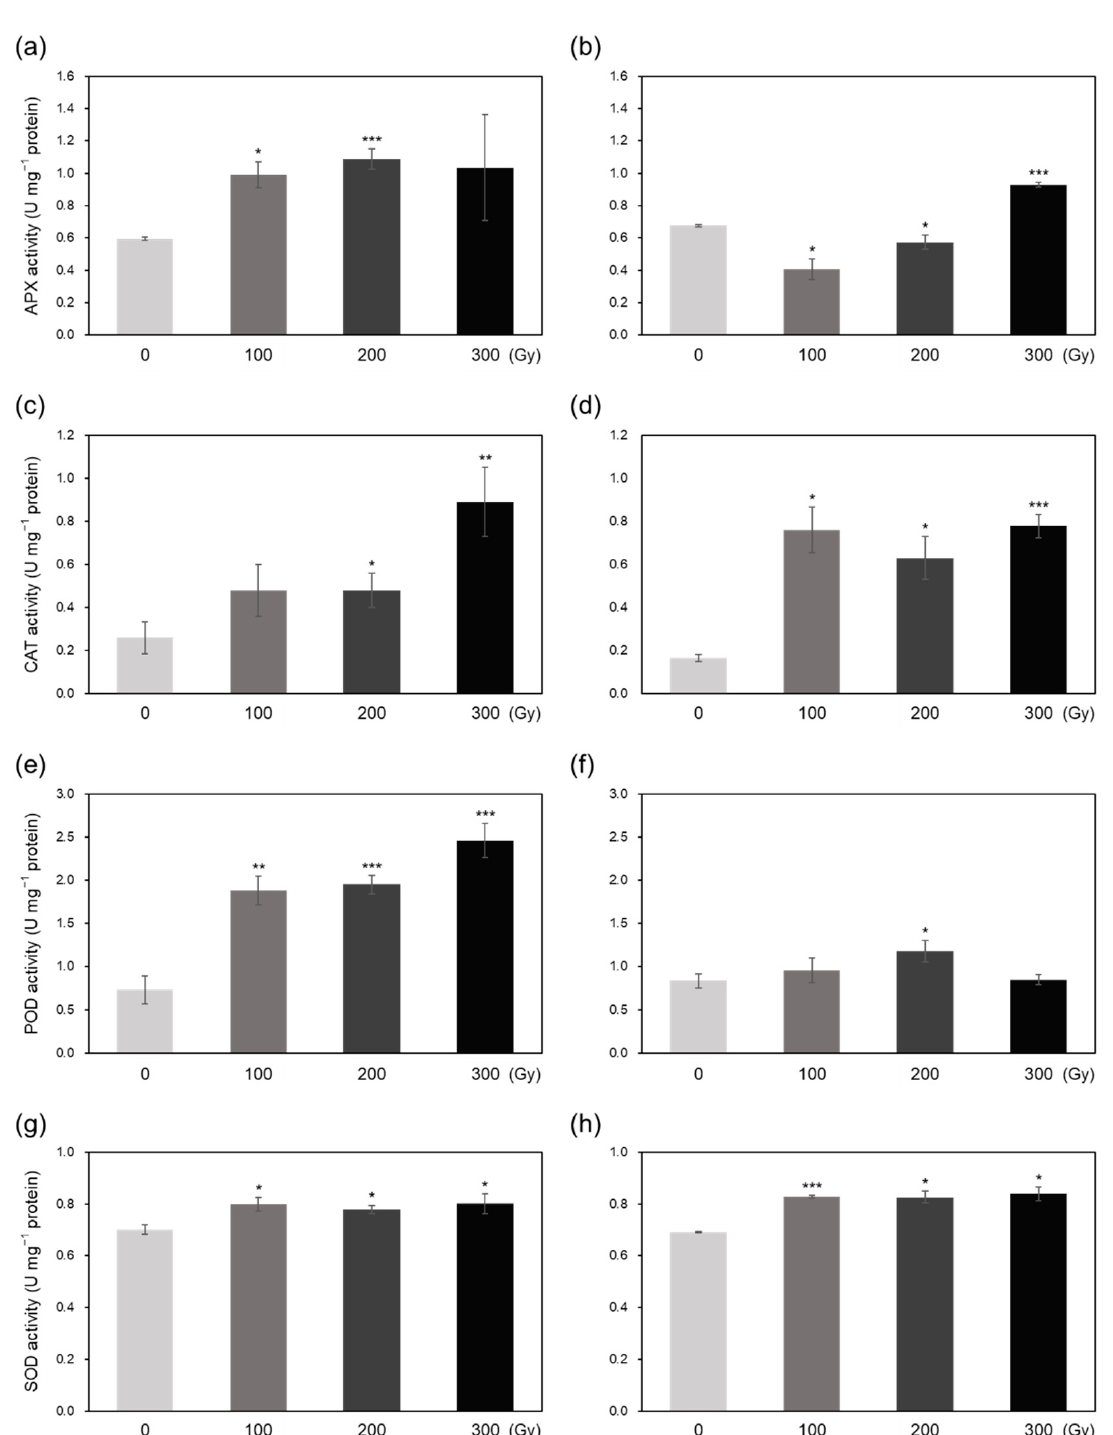
Figure 5. Measurement of antioxidant enzyme activities in rice plants. ( a – h ) Activities of ascorbate peroxidase (APX) ( a , b ), catalase (CAT) ( c , d ), peroxidase (POD) ( e , f ), and superoxide dismutase (SOD) ( g , h ) in plants subjected to acute ( a , c , e , g ) and chronic ( b , d , f , h ) gamma irradiation. Data represent mean ± SD. Asterisks indicate significant differences between the control (0 Gy) and other treatments (* p < 0.05, ** p < 0.01, *** p < 0.001).